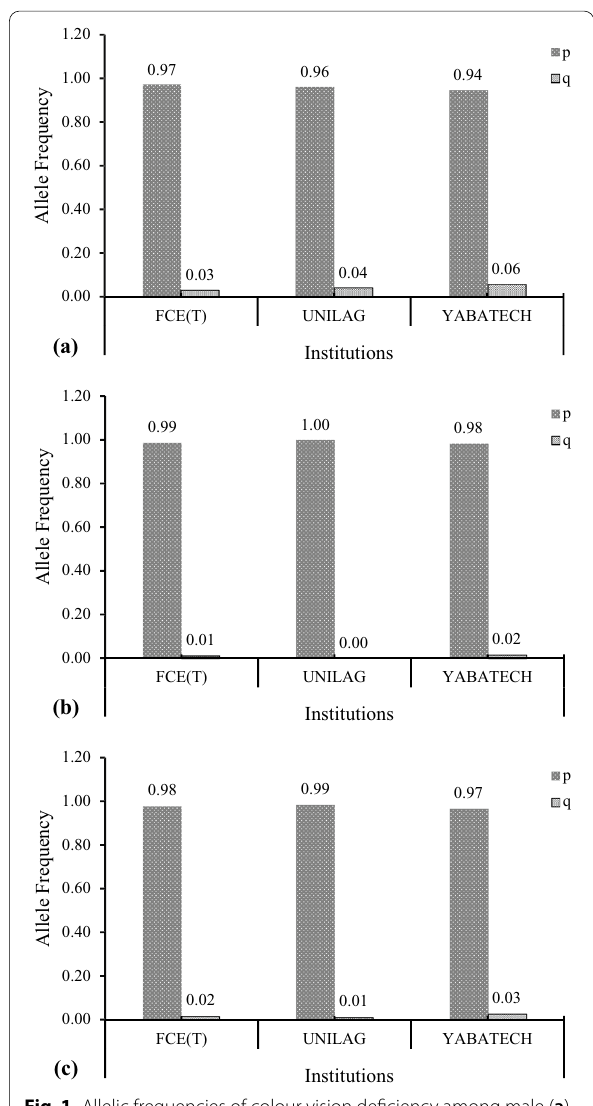
Fig. 1 Allelic frequencies of colour vision deficiency among male ( a ), female ( b ) and combined population ( c ) of students of the studied institutions